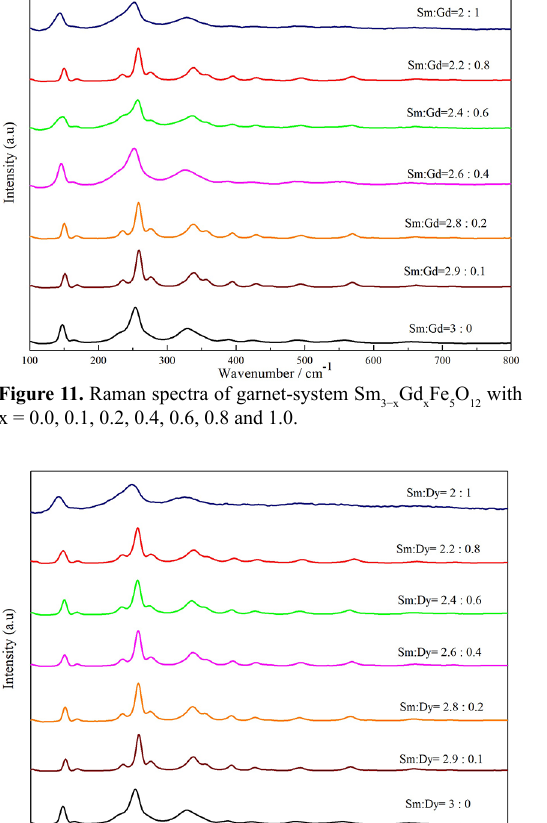
Figure 13. Raman spectra of garnet-system Sm x = 0.0, 0.1, 0.2, 0.4. 0.6, 0.8 and 1.0.